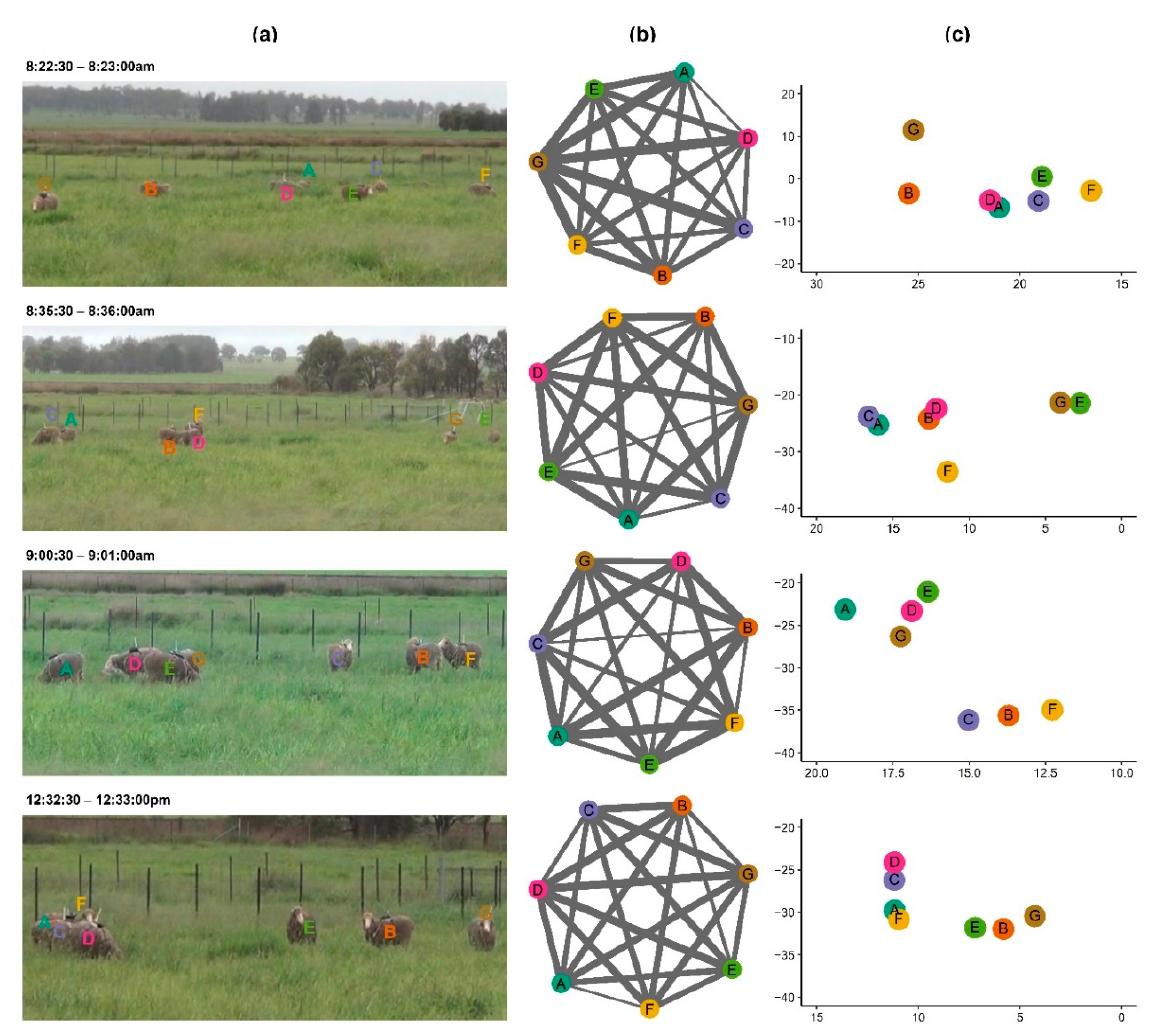
Figure 10. Animal social groups based on ( a ) recorded video ( b ), social network analysis, and ( c ) GNSS positional data at four time points on the third day of the study. In the social network plots, letters in the vertices (nodes) refer to individual animals and edges show the distance between two animals where a thinner line corresponds to a shorter distance and vice versa. Note: For each picture, the related social network graph and GNSS locational plot are in the same row.